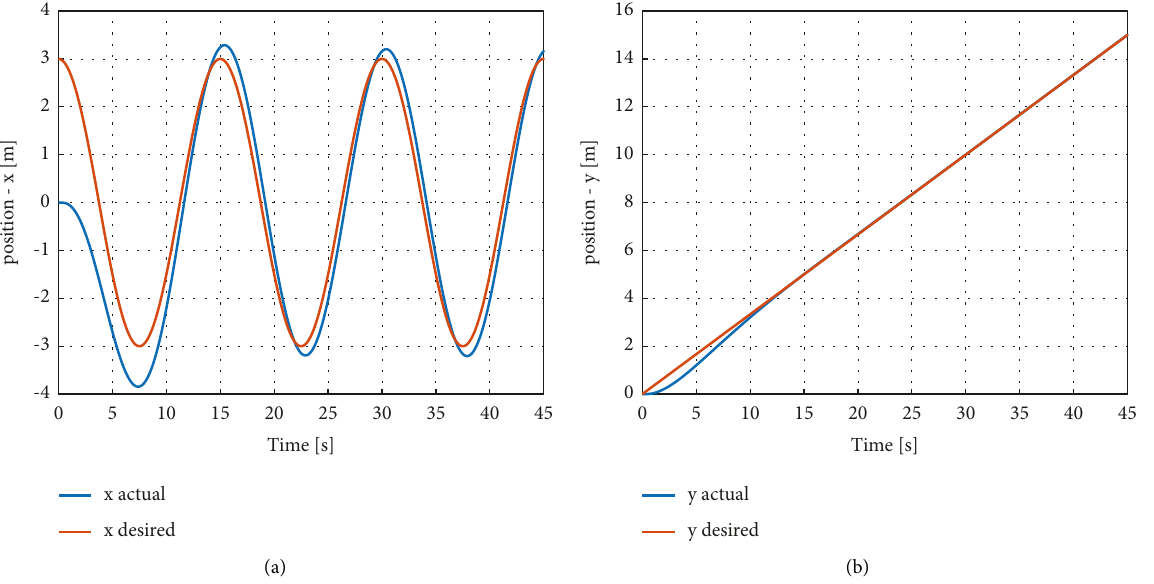
Figure 14: Coordinate-wise comparison between desired and actual trajectories of Figure 13.